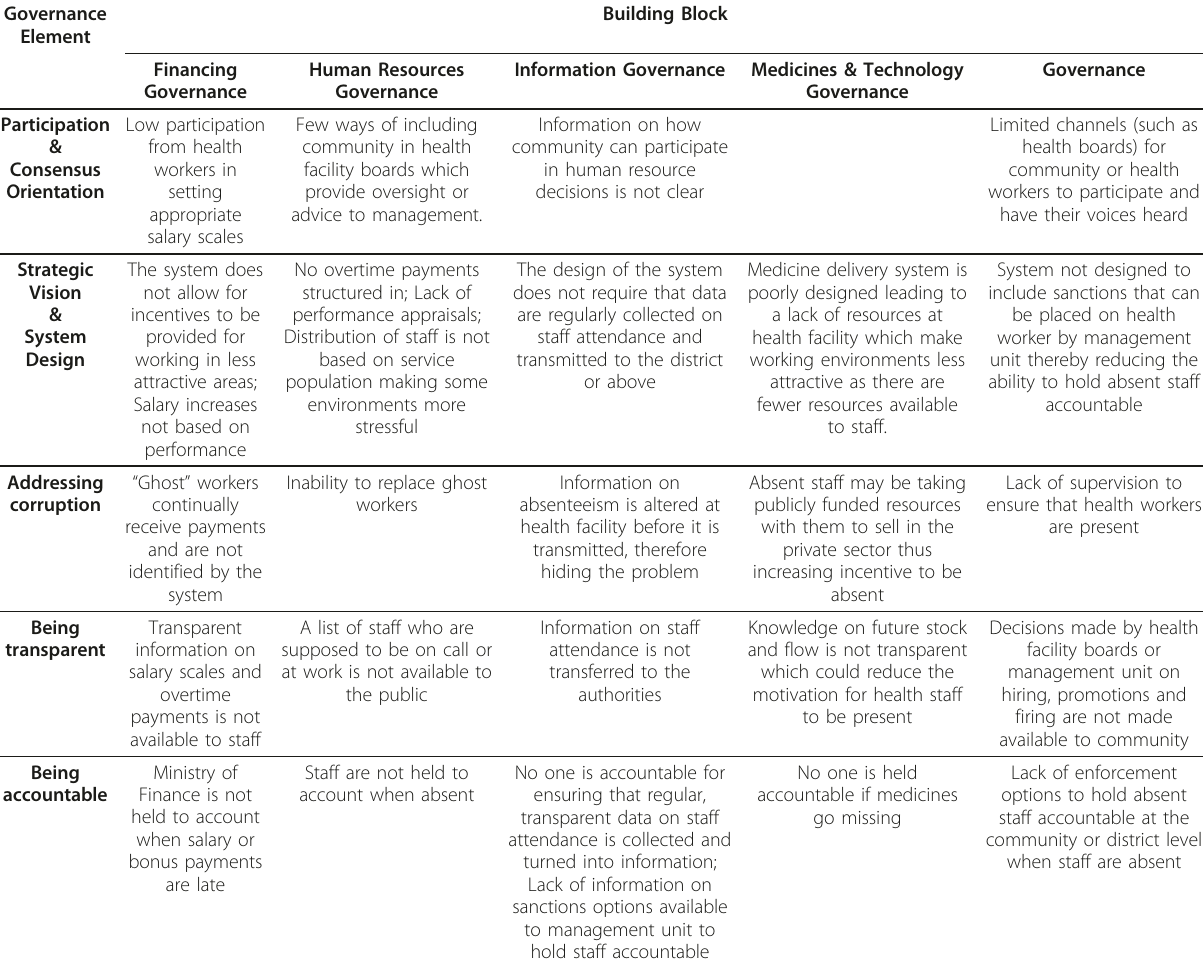
Table 3 Illustration of application of framework: Considering the determinants for unauthorized health worker absenteeism in public